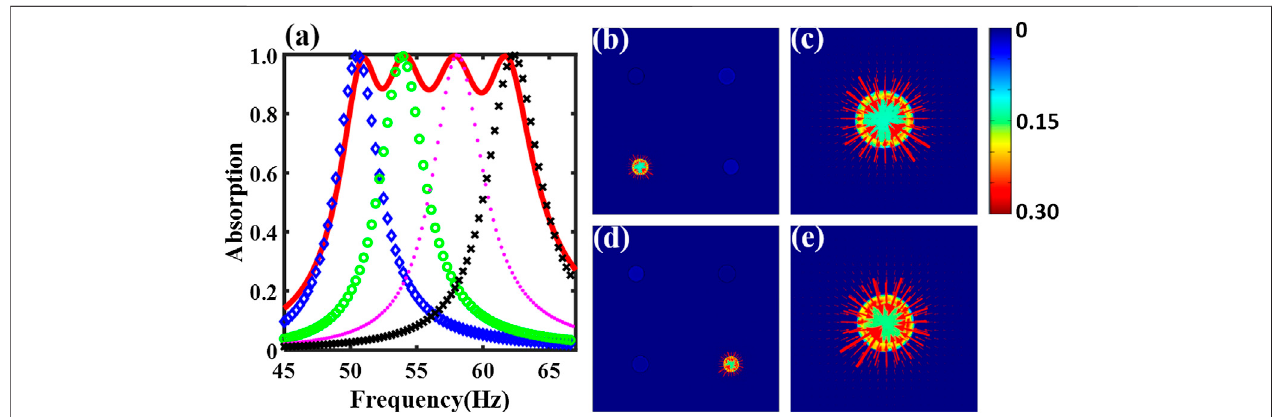
FIGURE 3 | (A) The theoretical absorption coef fi cient of the non-optimized supercell (red solid line) and individual unit cells (blue diamonds, green circles, magenta points and black crosses are for unit cell one, two, three, and four respectively). The curve for “ unit cell N ” is an absorption spectrum for a metasurface in which only unit cell N can interact withthe incident sound and all theother unit cellsare blocked at thefront panel. N (cid:1) 1, 2,3, 4. Sound intensity maps ofthe non-optimizedsupercellat (B) 53.6 Hzand (D) 57.8 Hz,respectively.Thebottom-leftunitcellof (B) andthebottom-rightunitcellof (D) areenlarged,asshownin (C) and (E) ,respectively.The incident pressure is normalized to 1 Pa. Color bar (w / m 2 ): component of the sound intensity vector that are perpendicular to the supercell surface, i.e., I z . Arrow: components of the sound intensity vector that are parallel to the supercell surface, i.e., I x and I y . The size of the arrows is proportional to the magnitude of the intensity.